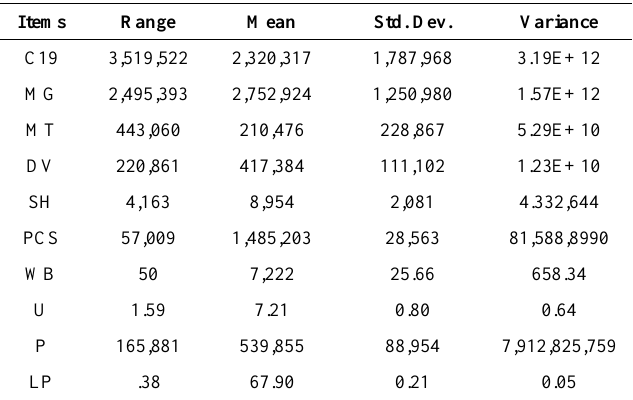
Table 2. Matrix of descriptive statistics